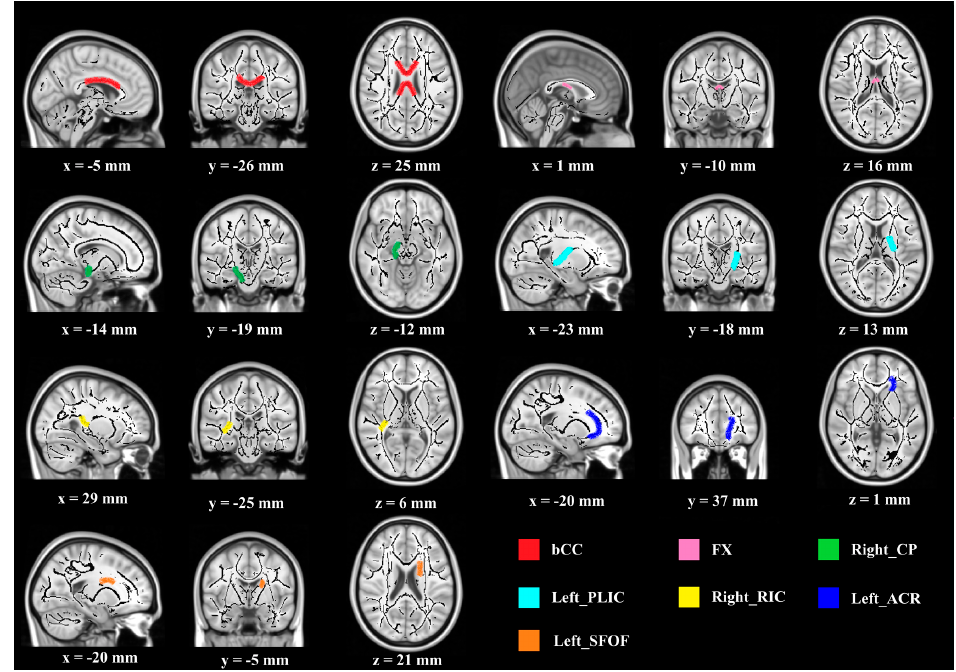
Figure 1. Demonstration of brain regions with significant FA increases after